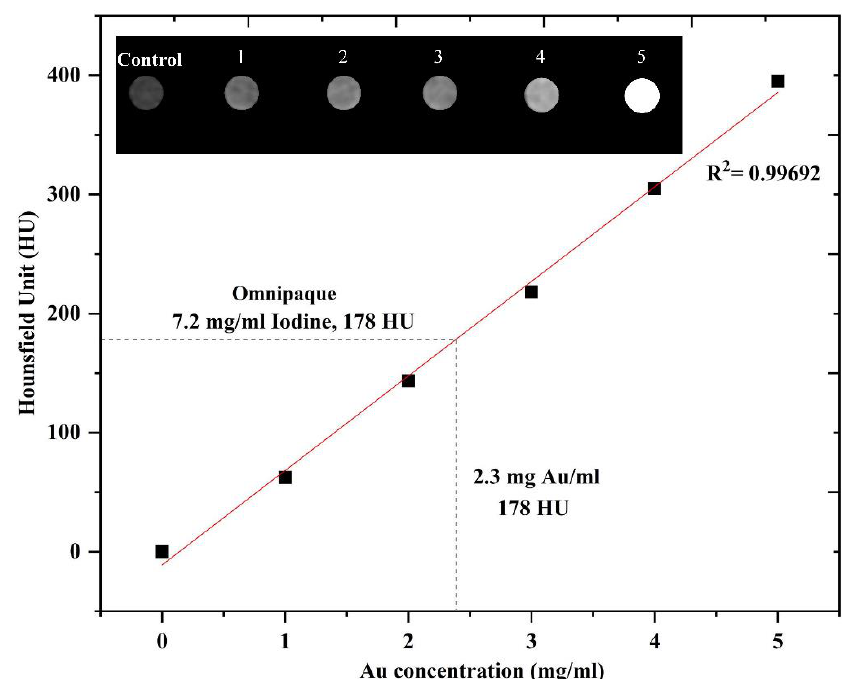
Figure 7. Computed tomography (CT) image of the AuNPs with different concentrations (1, 2, 3, 4 and 5 mg/mL) and X-ray attenuation intensity, the dotted line shows that 2.3 mg Au/mL gave an equivalent X-ray absorption as 7.2 mg/mL Iodine in Omnipaque (viz., 178 HU).